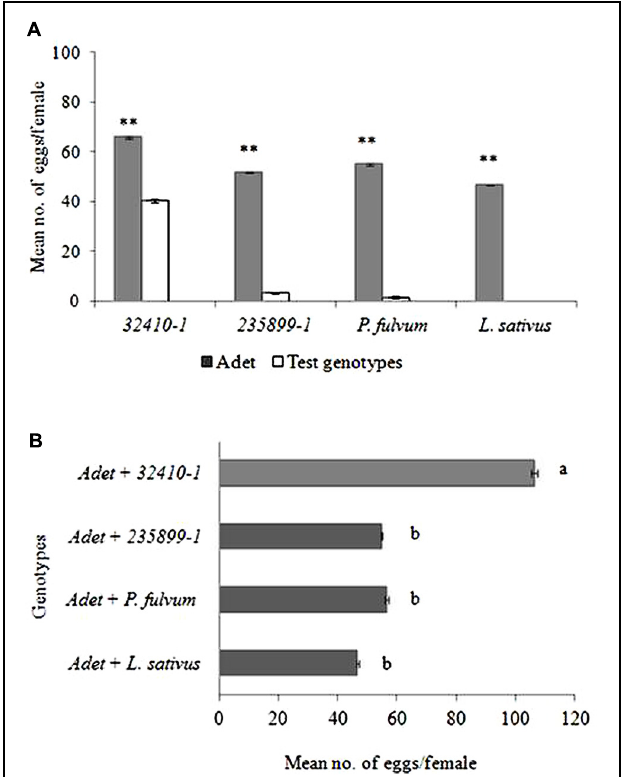
FIGURE 2 | (A) Distribution of eggs of pea weevil in dual-choice oviposition tests. (B) Total number of eggs laid by the pea weevil in the experiments where the susceptible genotype Adet was combined with other more resistant pea genotypes and non-host plants. Bars marked with different letters are significantly different (Tukey’s test: P < 0.001; ∗∗ P < 0.001). Bars indicate mean ± standard error (SE).